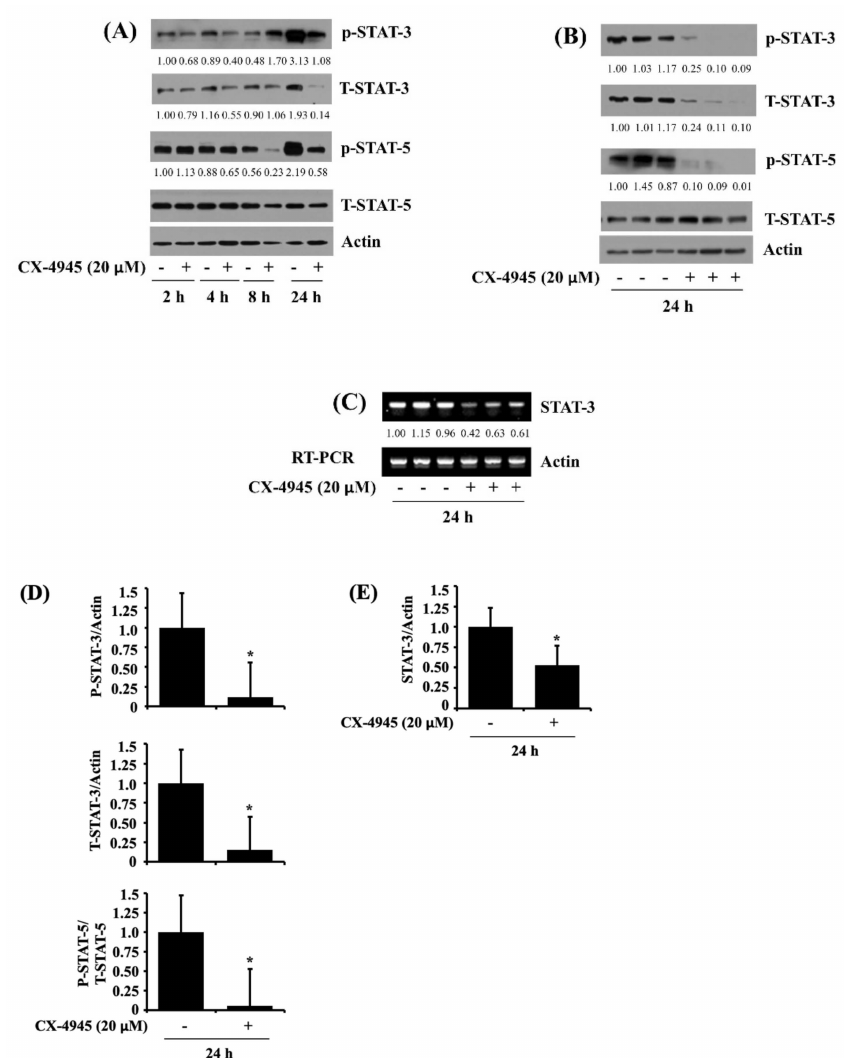
Figure 4. Effect of CX-4945 on expression and phosphorylation levels of STAT-3 and STAT-5 in HuCCT-1 cells. ( A ) HuCCT-1 cells were treated with CX-4945 (20 µ M) or vehicle control (DMSO) at indicated time points. At each time point, whole-cell lysates were prepared and analyzed for levels of p-STAT-3, T-STAT-3, p-STAT-5, T-STAT-5, or β -actin by Western blotting. ( B ) HuCCT-1 cells were treated with CX-4945 (20 µ M) or vehicle control (DMSO) in triplicate experiments at 24 h. Then whole-cell lysates were prepared and analyzed for levels of p-STAT-3, T-STAT-3, p-STAT-5, T-STAT-5, or β -actin by Western blotting. ( C ) HuCCT-1 cells were treated with CX-4945 (20 µ M) or vehicle control (DMSO) in triplicate experiments at 24 h. Total cellular RNA was extracted and analyzed for levels of STAT-3 or β -actin by RT-PCR with respective primers. ( D ) Densitometry analysis of ( B ). Data are mean ± SE of three independent experiments. * p < 0.05 compared to vehicle